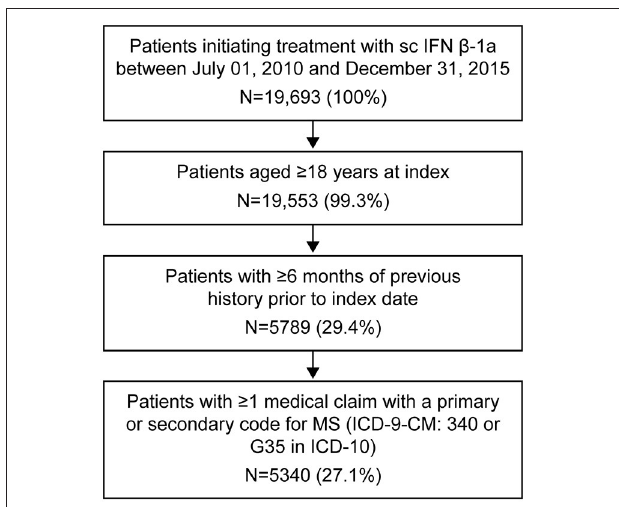
FIGURE 2 | Patient flow selection. ICD, International Classification of Diseases, Revision 9; MS, multiple sclerosis; sc IFN β -1a, subcutaneous interferon